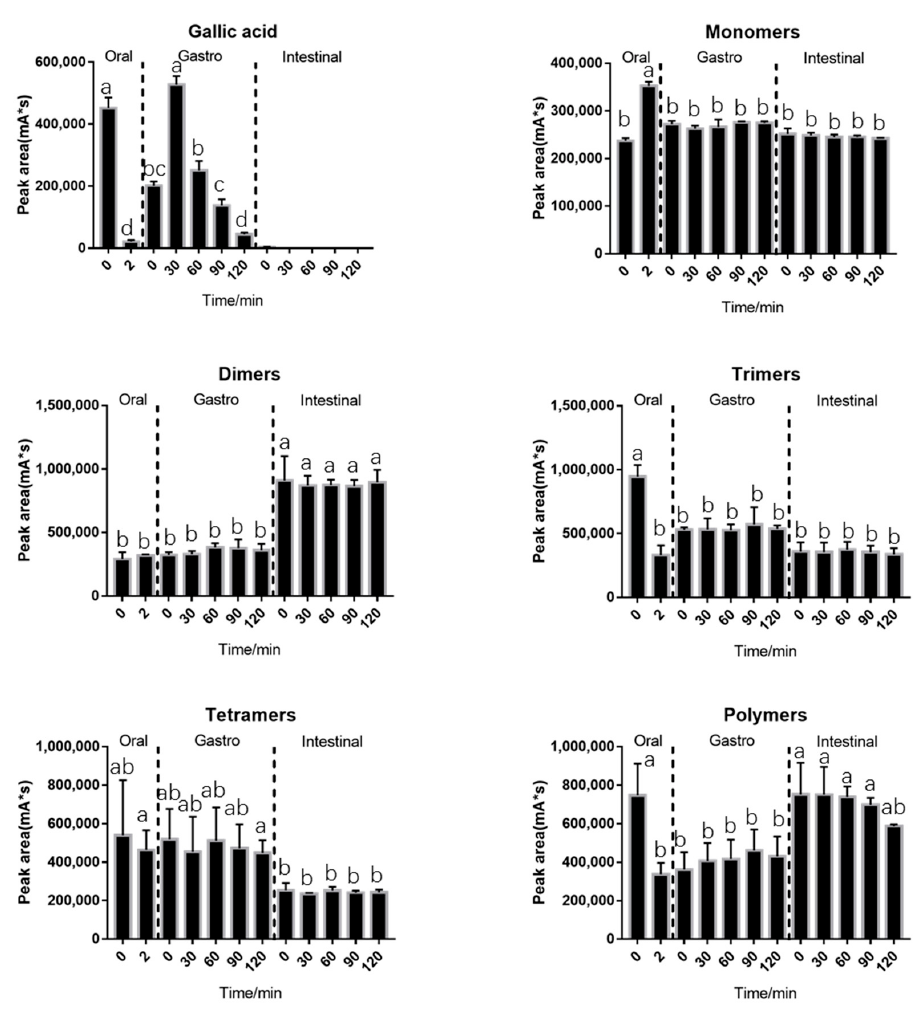
Figure 1. Changes of gallic acid and different degrees of polymerization (DPs) of proanthocyanidins during in vitro digestion. Statistical significance ( p < 0.05) is expressed by different letters.